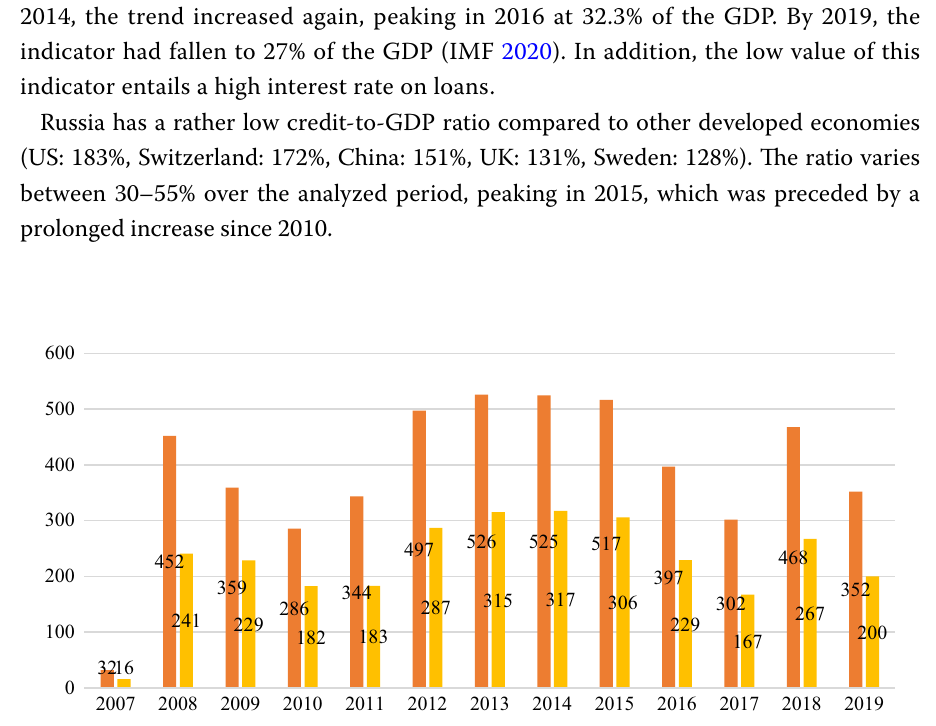
Fig. 3 Dynamics of export (orange) and import (yellow) in Russia in 2007–2019. Sources : Goskomstat